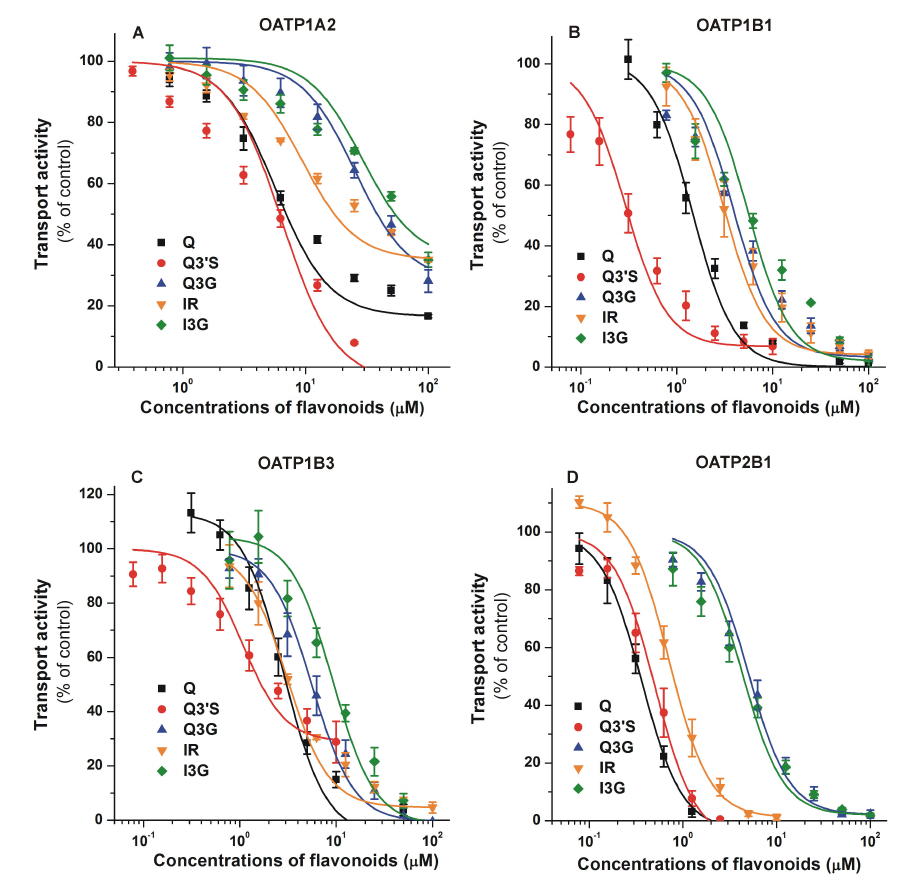
Figure 3. Concentration-dependent inhibitory e ff ects of Q, Q3 (cid:48) S, Q3G, IR, and I3G on the transporter functions of organic anion-transporting polypeptides: OATP1A2 ( A ), OATP1B1 ( B ), OATP1B3 ( C